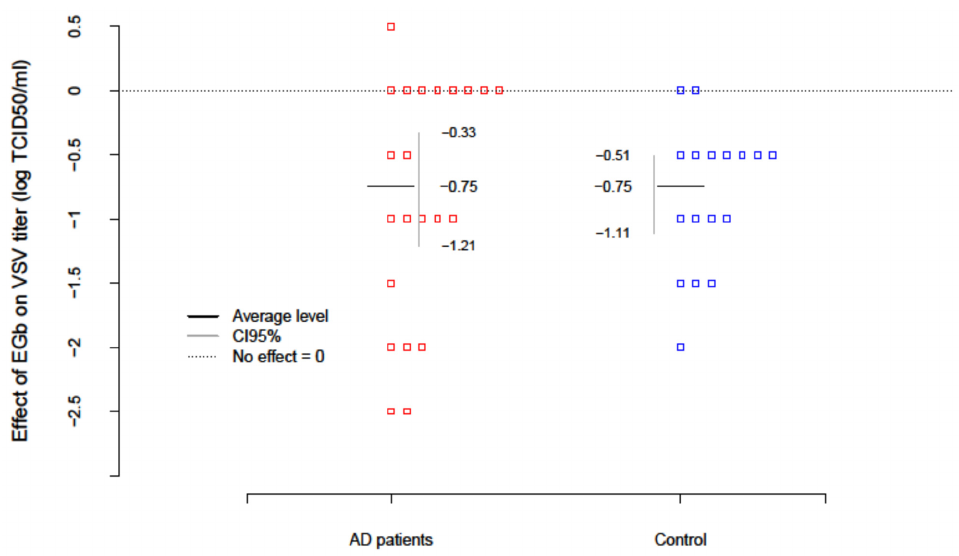
Figure 1. EGb effect on VSV replication (level of innate immunity) in PBLs from AD patients and healthy age-matched controls. EGb effect was measured as difference between VSV titer (log TCID 50 /mL) after EGb treatment and VSV titer (log TCID 50 /mL) before EGb treatment. Red and blue squares are individual observations.